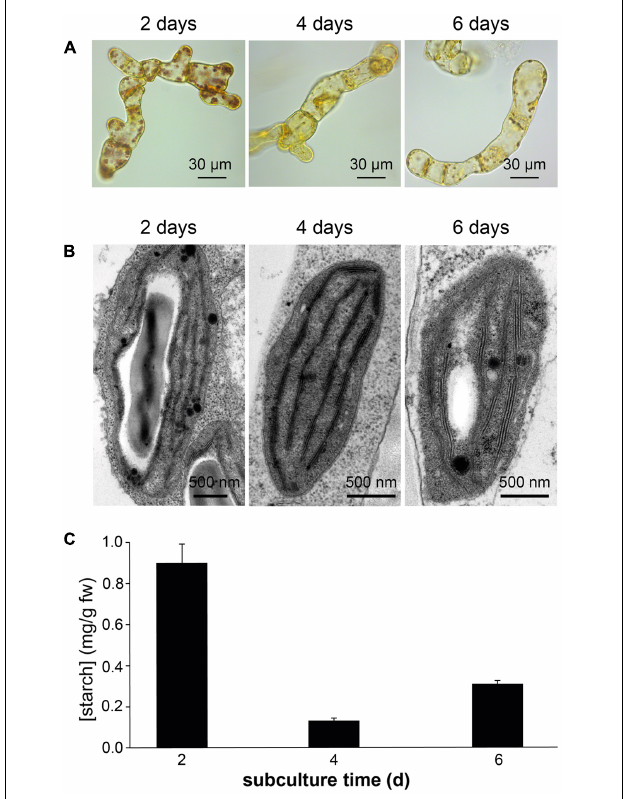
FIGURE 3 | Detection of starch in Arabidopsis photosynthetic cell cultures at different subculture times. Determinations of starch was carried out in suspension-cultured cells after 2, 4, and 6 days of subculture by Lugol staining (A) , TEM analyses (B), and a quantitative biochemical assay (C) .